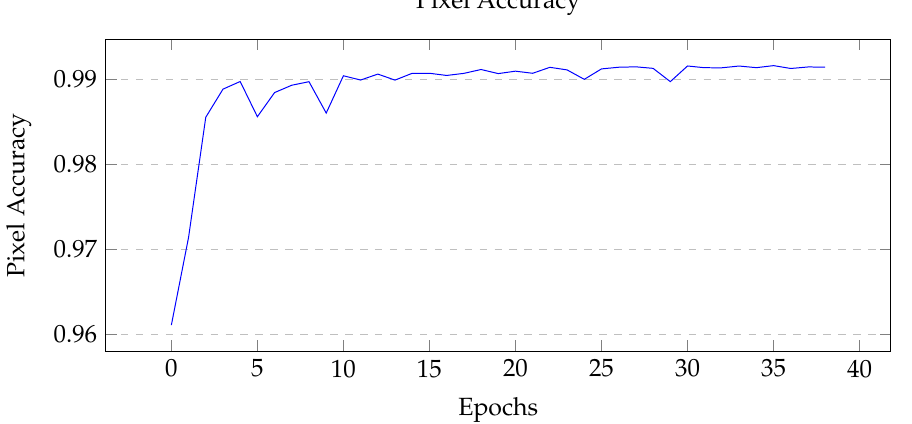
Figure 8. Graph of pixel accuracy over each epoch. Initial increase then gradual improvements. Notice the range of pixel